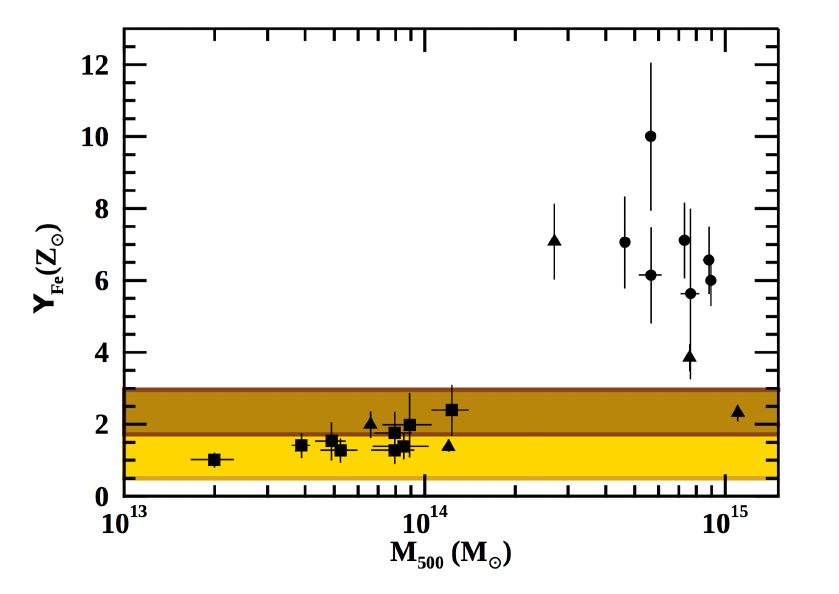
Figure 7. Effective iron yield Y Fe, (cid:12) for the clusters in the sample of Ghizzardi et al. [9] (circles), for the groups in the sample of Renzini and Andreon [8] (squares) and for the additional objects (NGC 1550, MKW 4, Hydra A, Perseus, and Coma in order of increasing mass) in the sample of Sasaki et al. [75] (triangles) as a function of the total mass of the system. We estimated stellar masses for the objects of Sasaki et al. [75] converting their L K optical luminosities to stellar masses, assuming a stellar mass-to-light ratio in the K-band of 1 consistent with stellar population models for a Kroupa IMF [161] and with observational results [169–171]. The yellow band shows the expected value computed through the SN yields derived from Maoz and Graur [165] and Renzini and Andreon [8]; the brown band represents the expected value derived assuming a higher SNIa rate in galaxy clusters than in the field, following Freundlich and Maoz